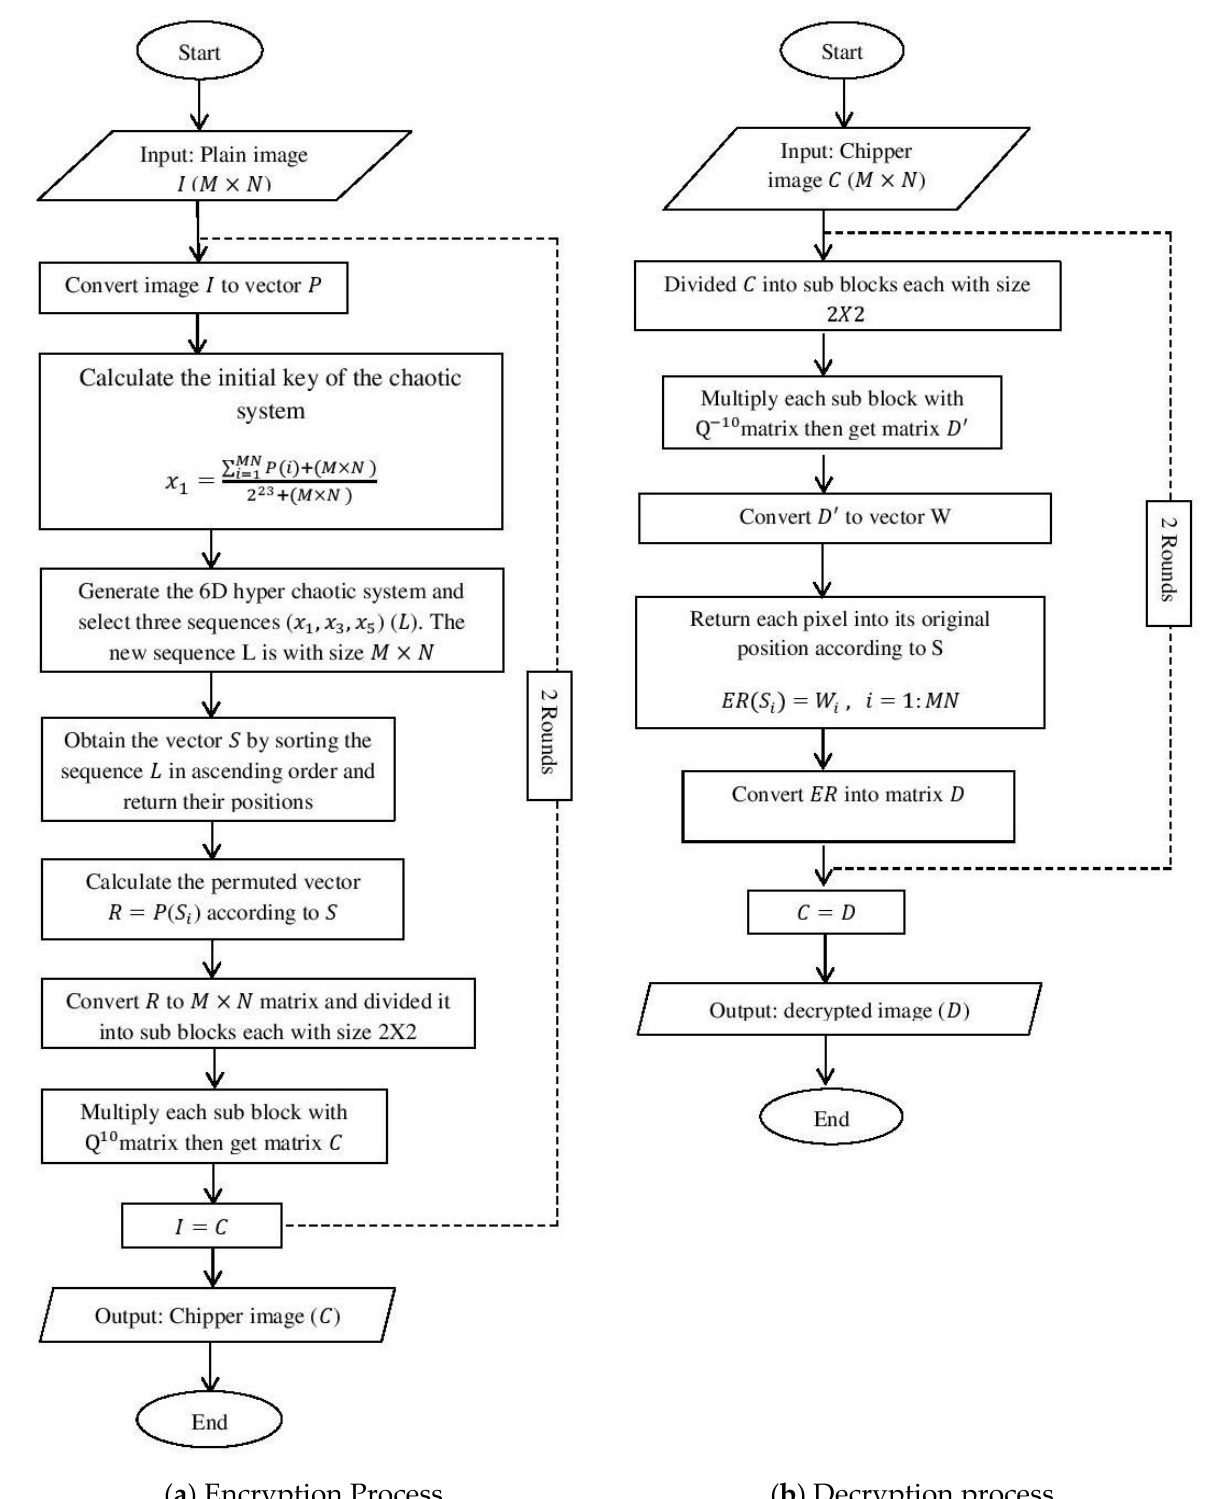
Figure 1. Flow chart of the proposed algorithm.